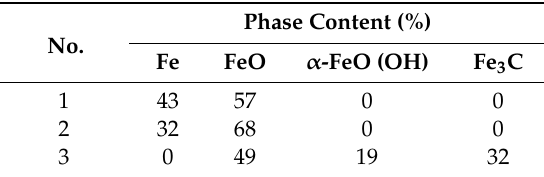
Table 2. Phase content of iron and iron compound of the recovered samples produced by pulsed iron wire